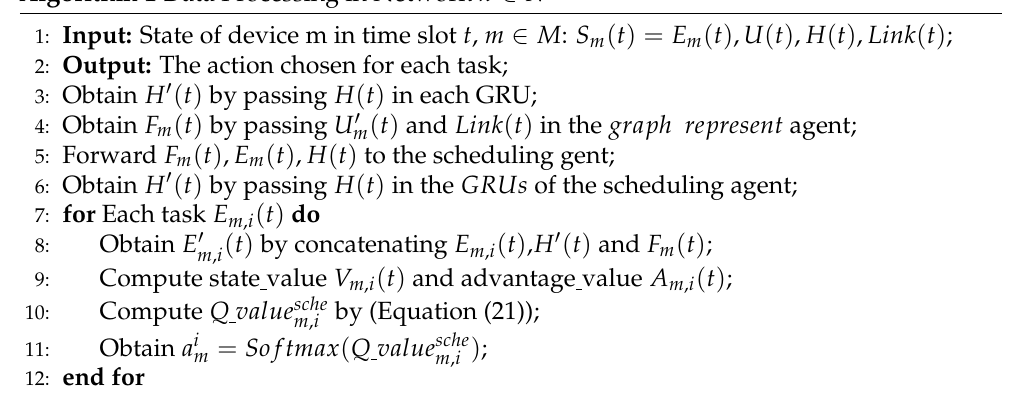
Algorithm 1 Data Processing in Network n ∈